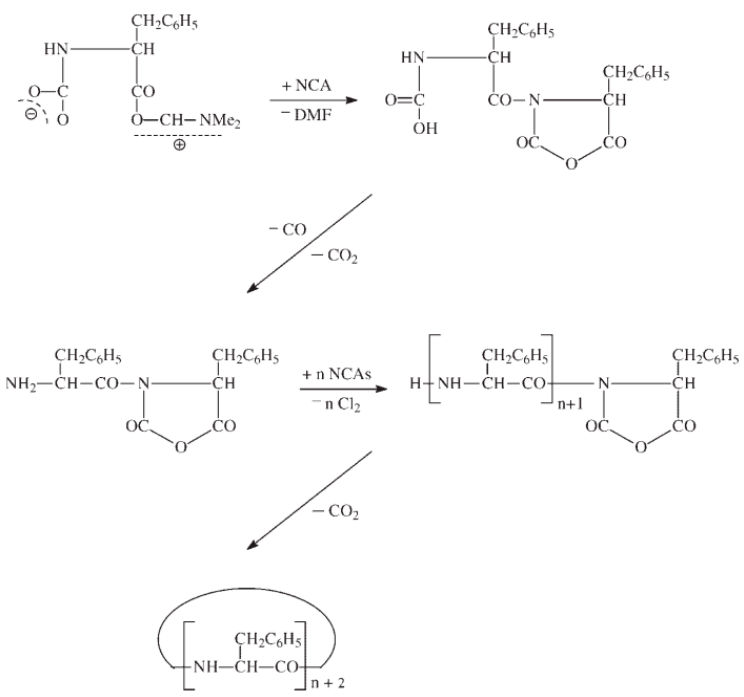
Figure 36. Formation of cyclic oligo-/polypeptides via N -acyl NCA end groups.